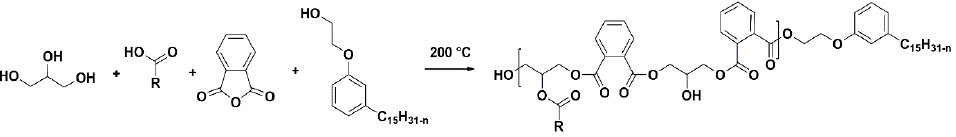
Scheme 1. General synthesis of EC alkyd